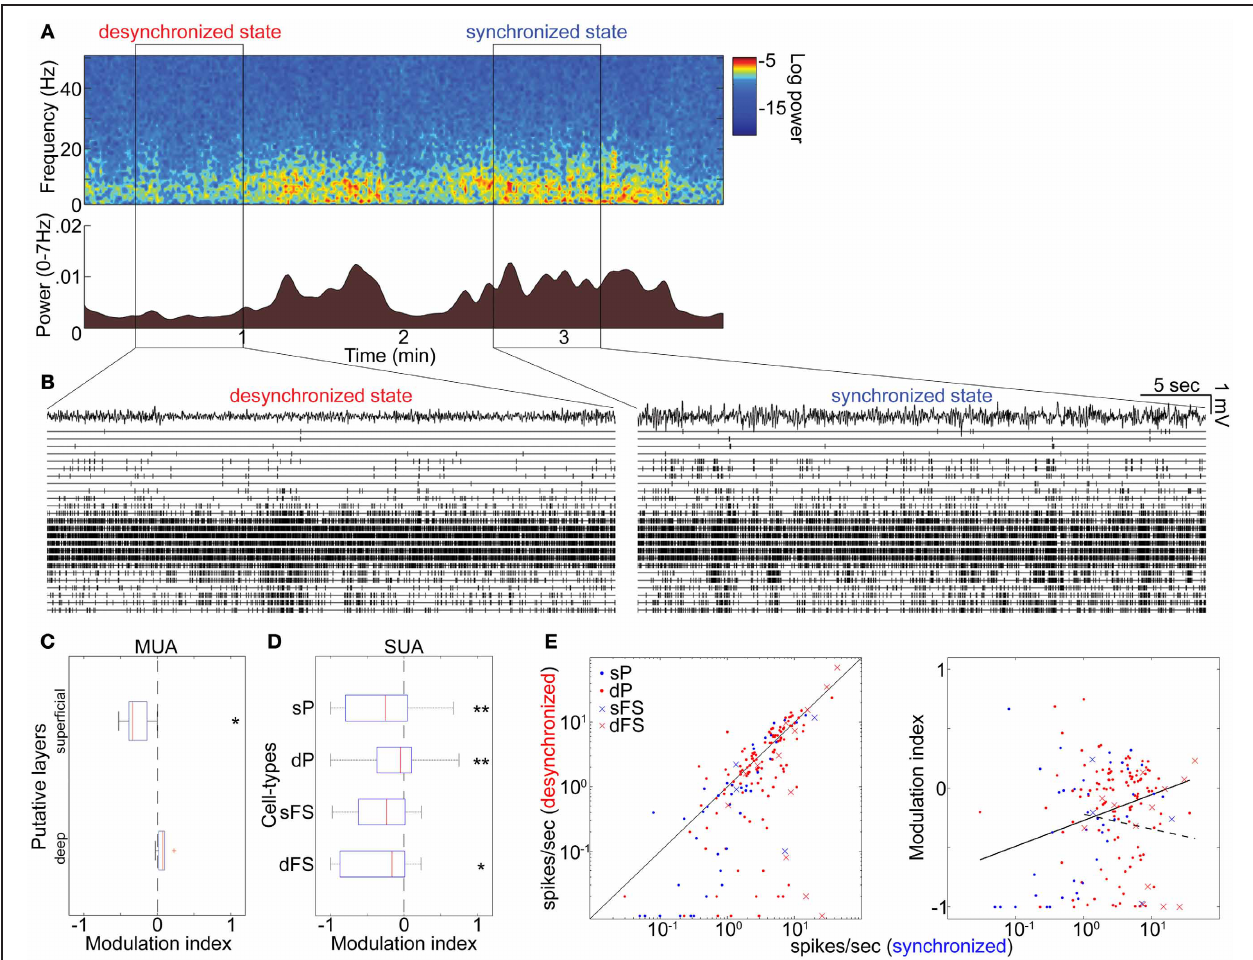
index of extracellularly classified single-unit activity (SUA) in putative L2/3 and L5. ∗ p < 0 . 05 and ∗∗ p < 0 . 005 (signed-rank test). (E) Firing rate during the synchronized state plotted against that during the desynchronized state ( left ) and modulation index ( right ) for putative PCs and putative FSs. Solid line in left panel corresponds to equality; that in right panel is linear regression fit for putative PCs. Dotted line in right panel is linear fit for putative FSs. Linear fitting was done with a semi-logarithmic